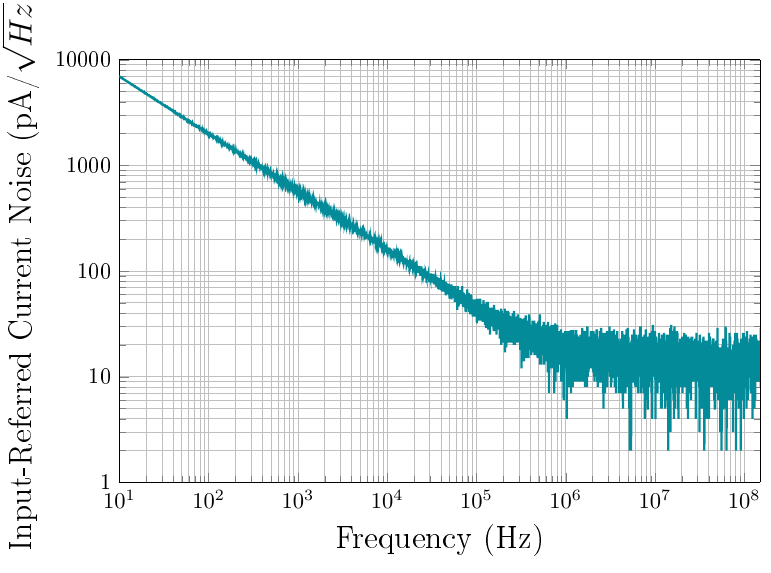
Figure 9. Measured TIA input-referred current noise.